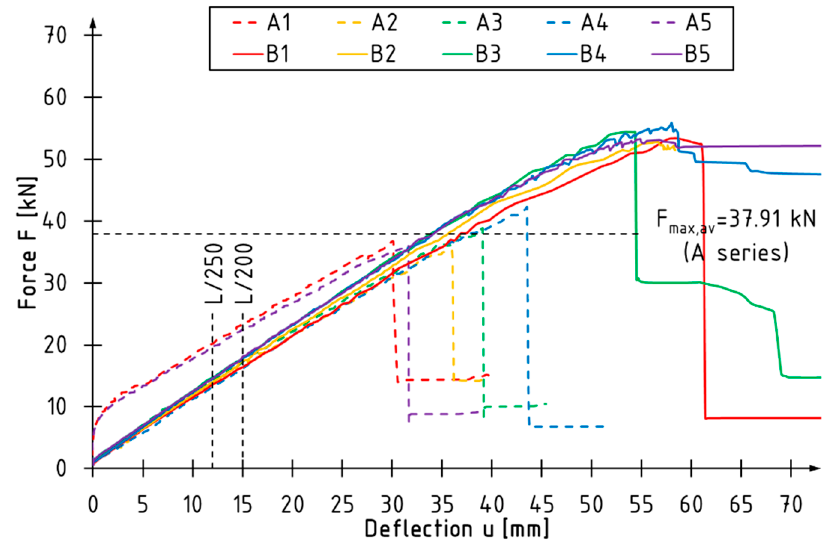
Figure 3. Load-deflection curves of B series beams.